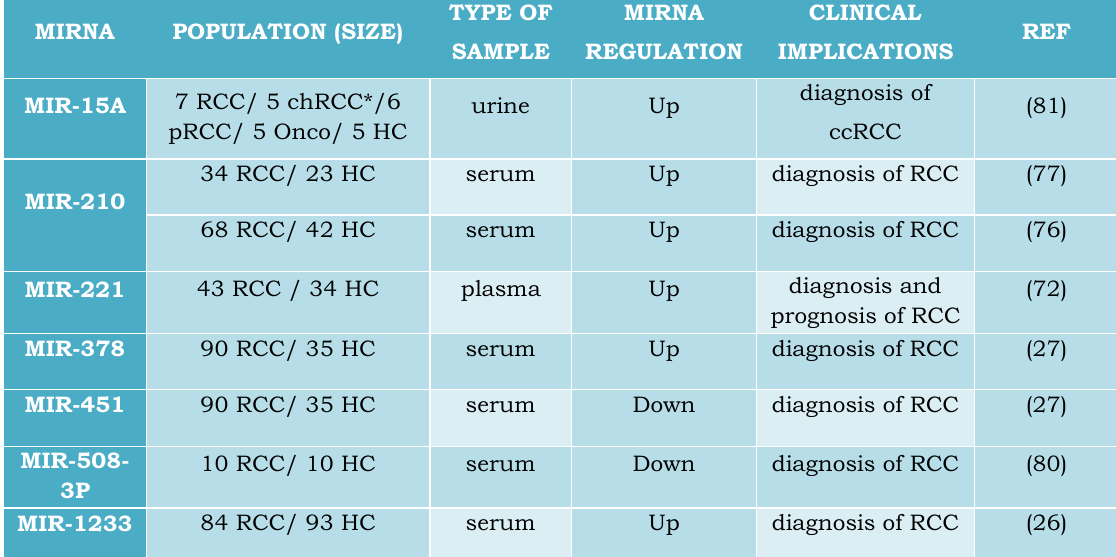
Table 1. Summary of circulating miRNAs detected in RCC patients TYPE OF MIRNA POPULATION (SIZE)